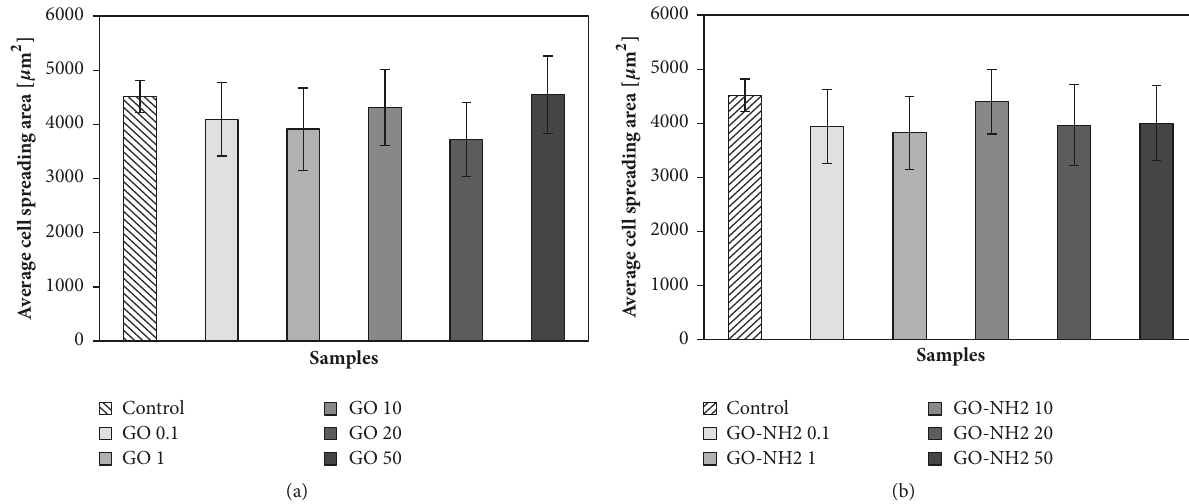
Figure 7: Average cell spreading area of A549 cells after 24 hours incubation in the presence of ( 1 ) GO and (b) GO-NH 2 .